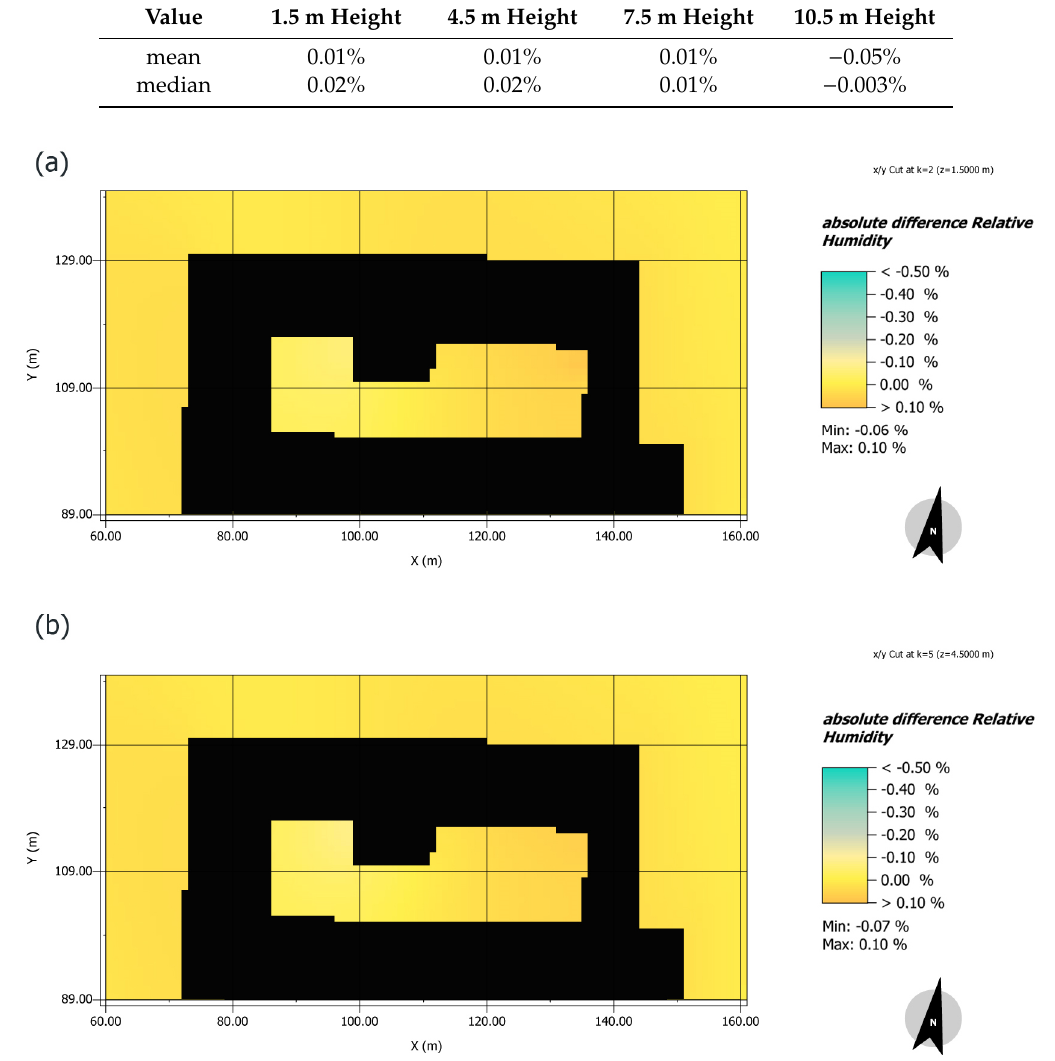
Table 4. Means and medians for next planar cuts of green roof case in the context of the whole atrium interior relative humidity. Numbers with minus signs should be read as an increase from the initial state.